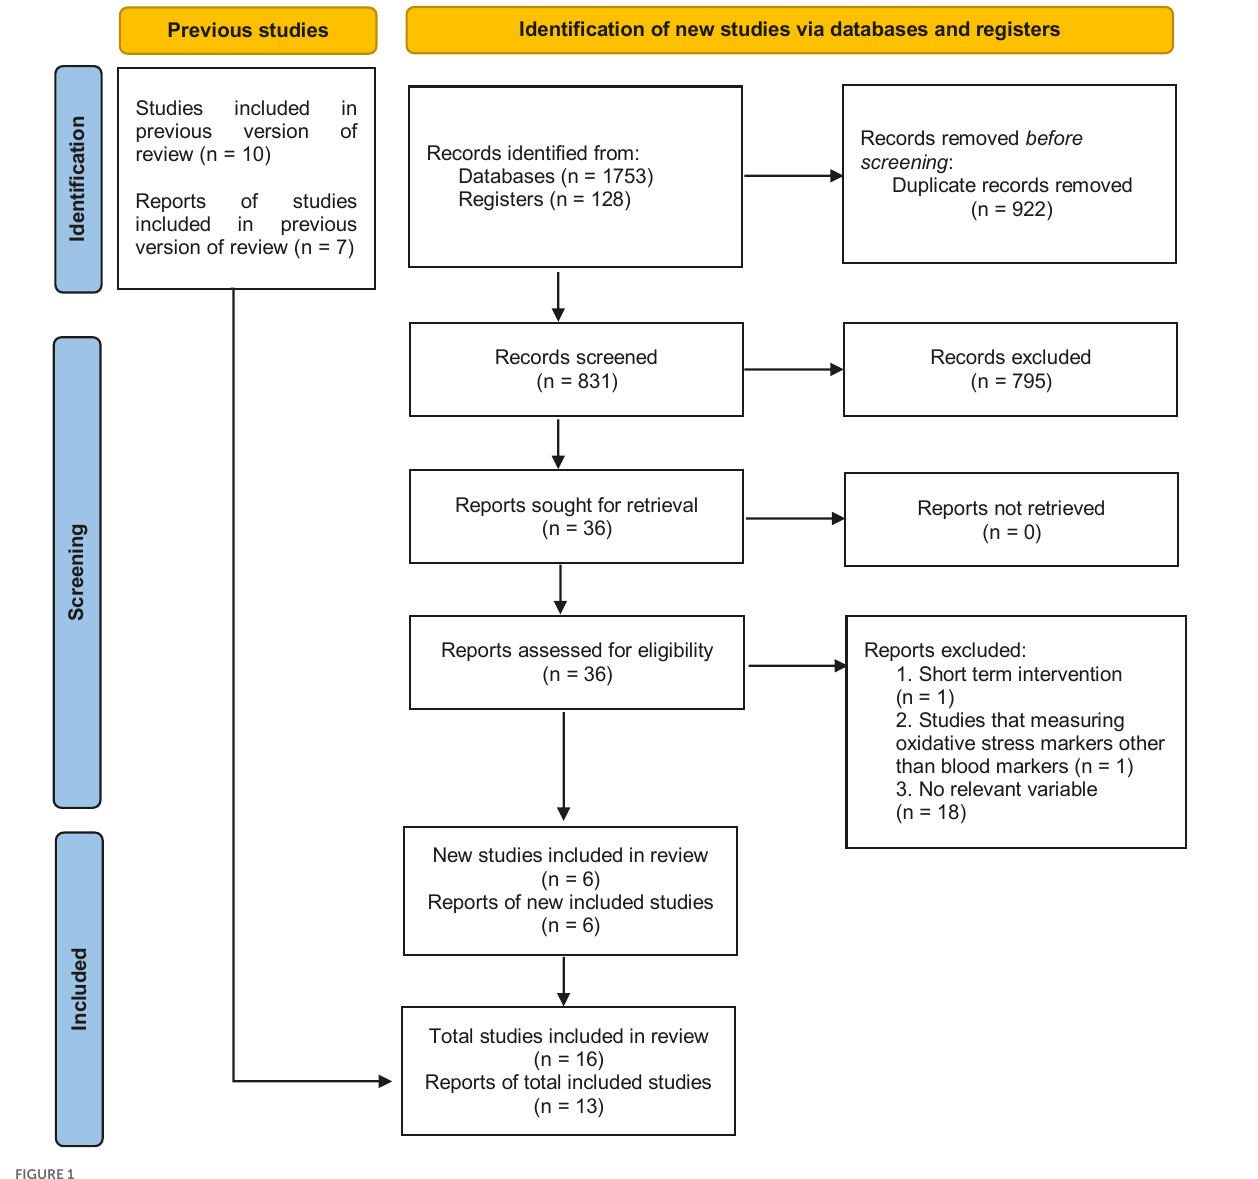
FIGURE1 Preferred Reporting Items for Systematic Reviews and Meta-Analyses (PRISMA) flow